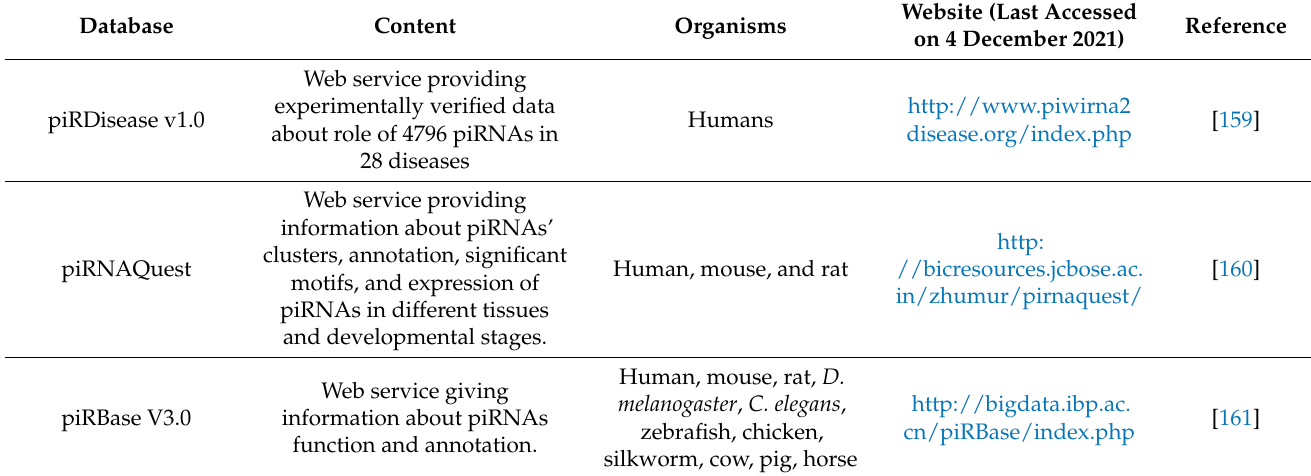
Table 2. Bioinformatic tools for analysis of piRNAs sequences and prediction of its